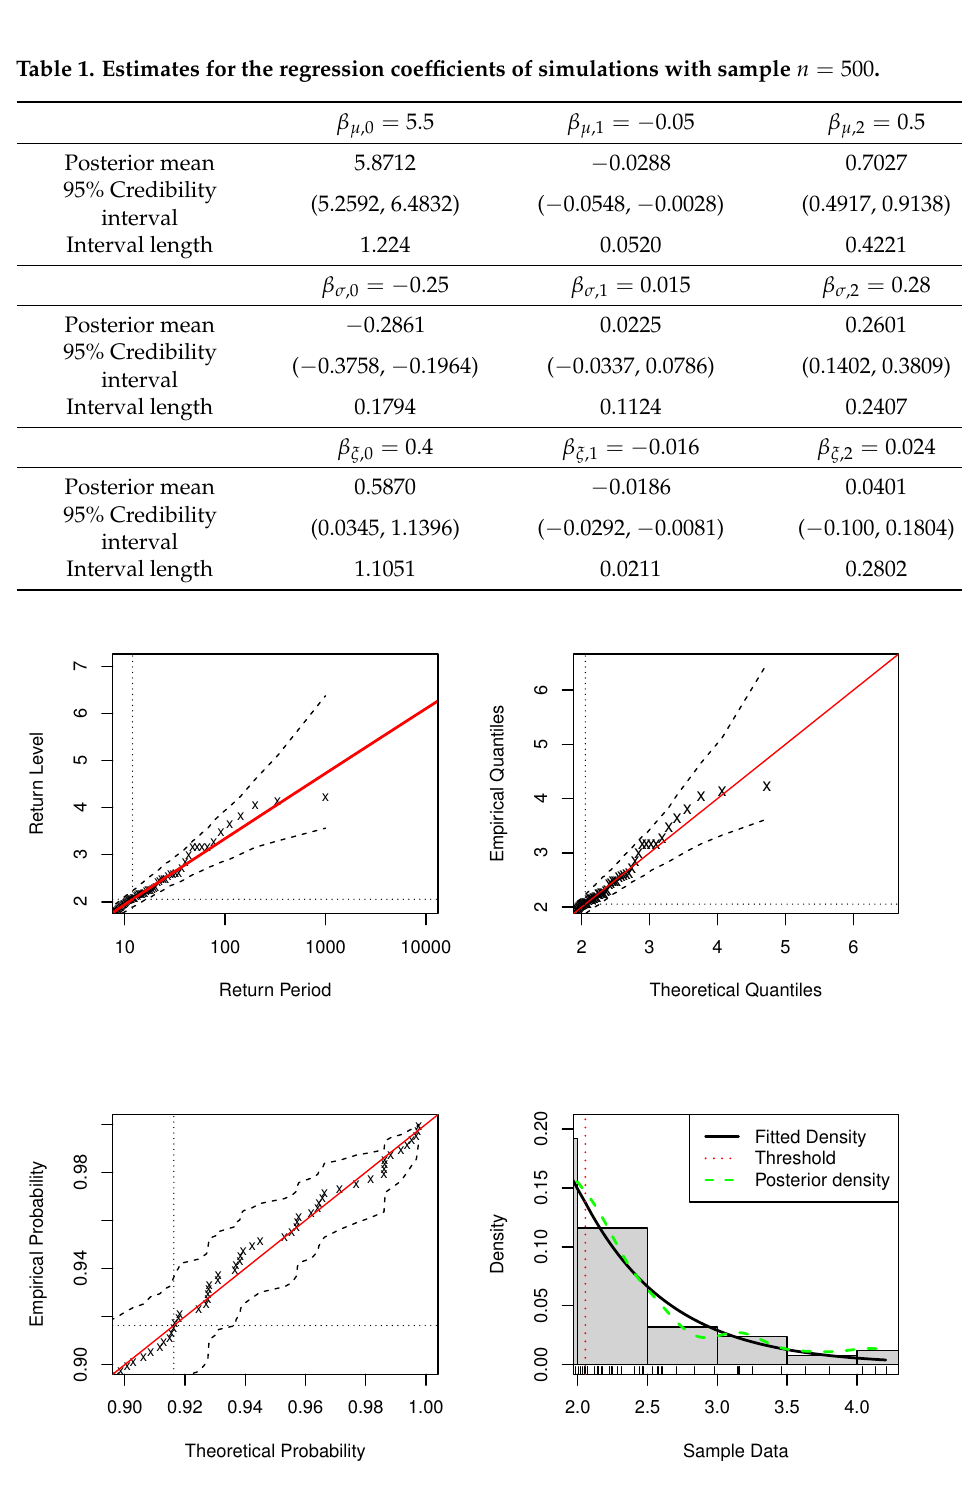
Figure 1. Standard model fit diagnostics for the upper tail of the DPMW-PPR model fitted to the simulated data with n = 500. (The top left corner is the return level plot, the top right corner is the quantile plot, the bottom left corner is the probability plot, and the bottom right corner is the density